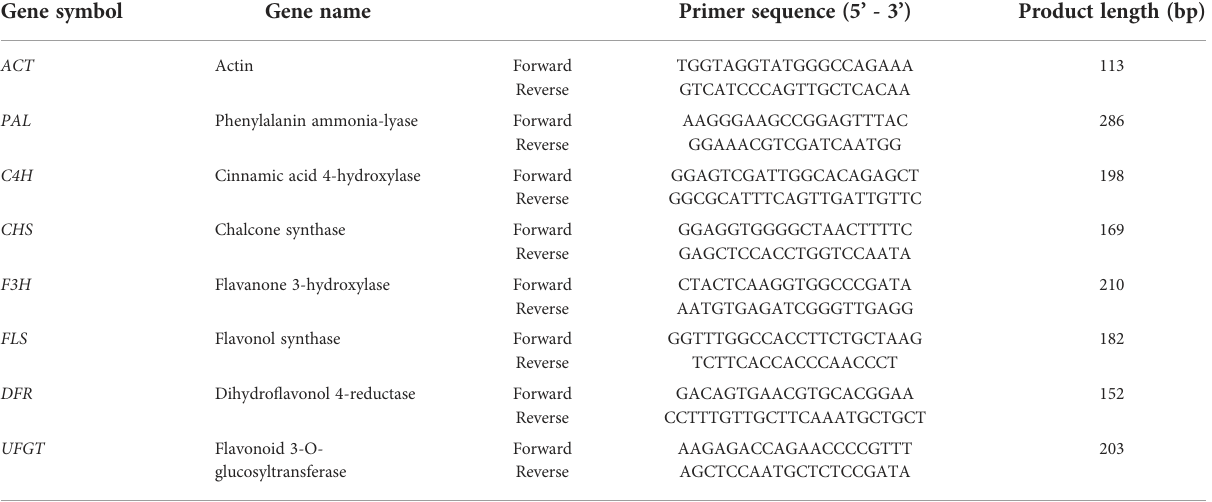
TABLE 2 Primers for internal standard gene and genes used in real time